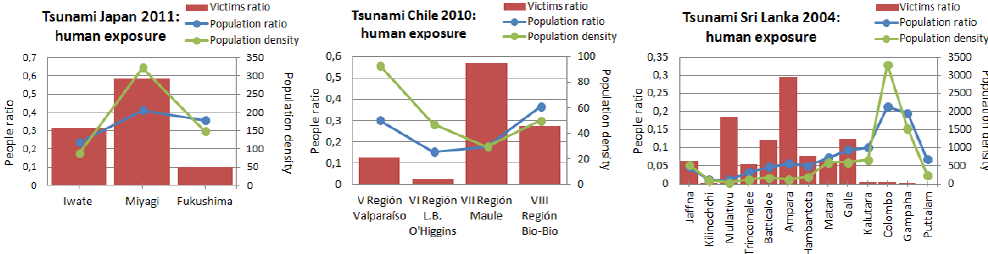
Figure 1. Correlation between tsunami victims ratio, population ratio and population density (tsunami events of Japan 2011, Chile 2010 and Sri Lanka